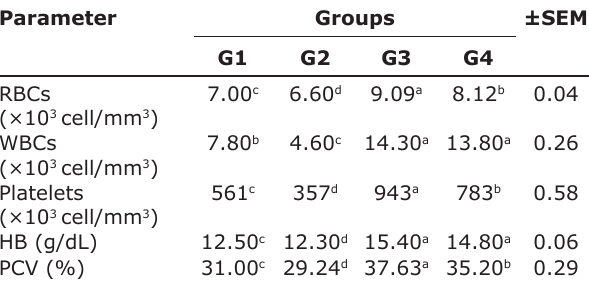
Table-2: Hematological studies of infected, treated, and control groups.